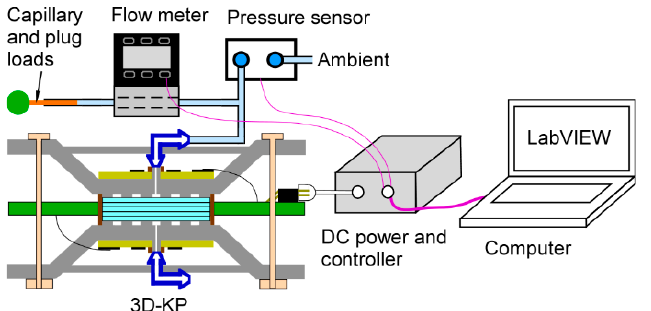
Figure 7. Testing setup for 3D-KPs. A flow meter is connected downstream of the KP and a pressure sensor is connected in parallel with the KP. Flow loading is adjusted using a capillary tube and a rubber plug. The pumping direction and power levels are controlled by the LabVIEW program.